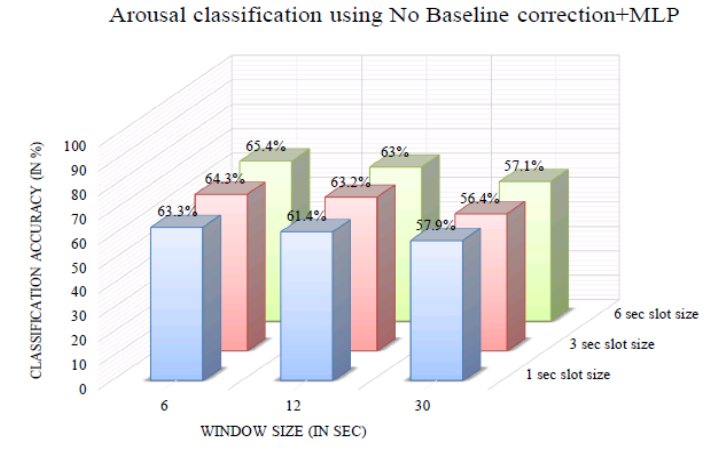
Figure 8. Arousal classification accuracy of NBC+MLP method for various window sizes.